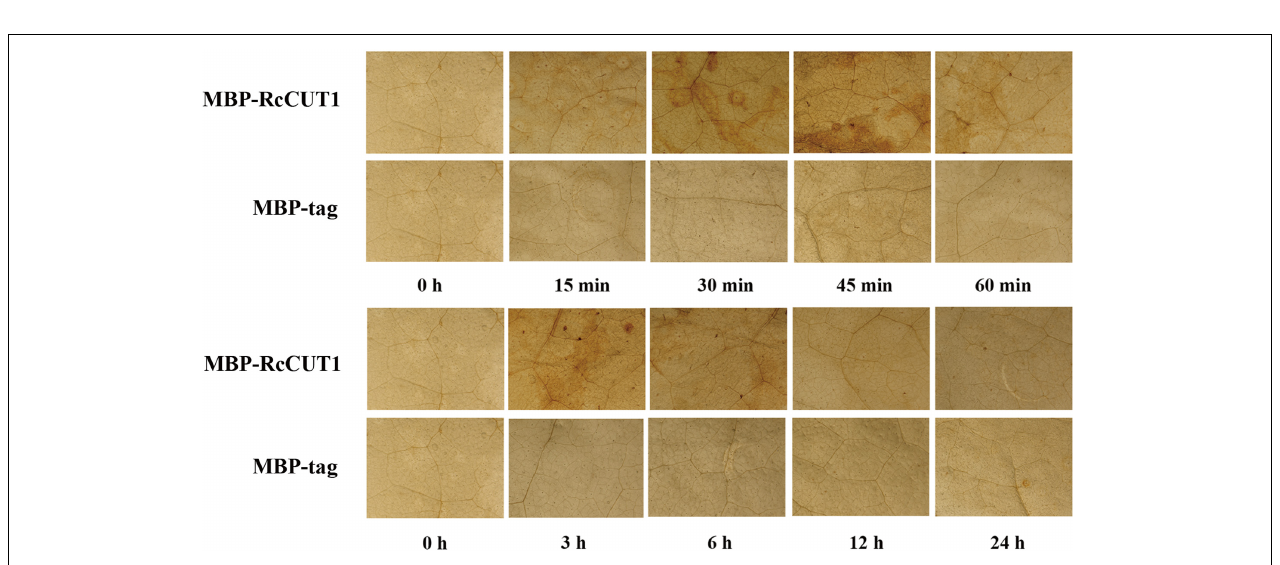
FIGURE 6 | Microscopic observation of H 2 O 2 accumulation in N. benthamiana leaves in response to RcCUT1. H 2 O 2 accumulation (as indicated by diaminobenzidine staining) appeared in the veins and stomata of MBP-RcCUT1-treated leaves but not in leaves treated with 5 µ M MBP-tag solution.